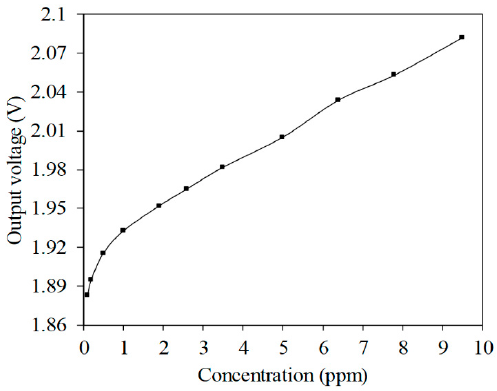
Figure 14. Output voltage of the AGS.